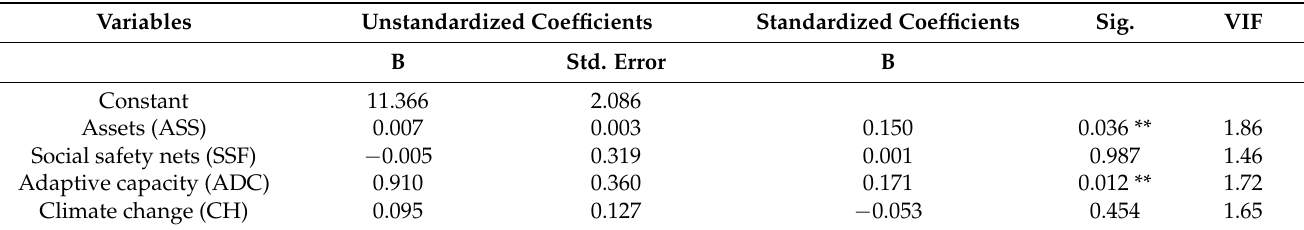
Table 6. Structural equation modeling results